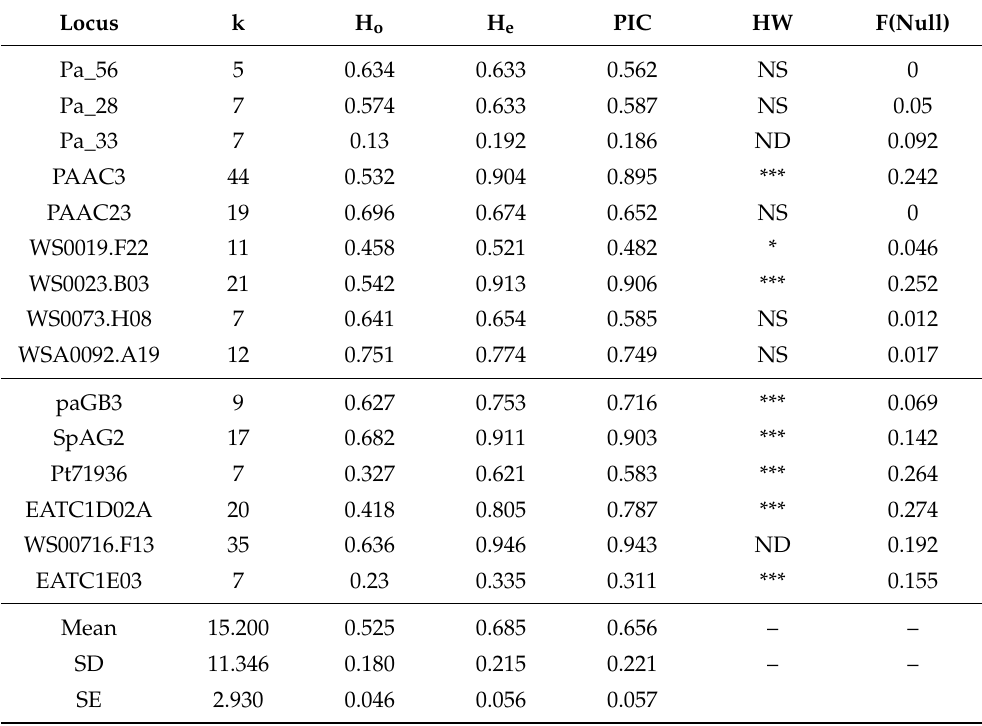
Table 1. Frequency-based statistics on analyzed